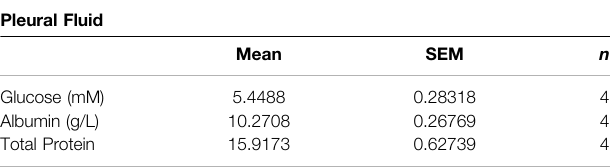
TABLE 1 | Composition of ascites in Gs α ECKO mice. Pleural fl uid was collected fromthethoraxofGs α ECKO miceandanalyzedforbiochemicalcontents; n =4. Pleural Fluid